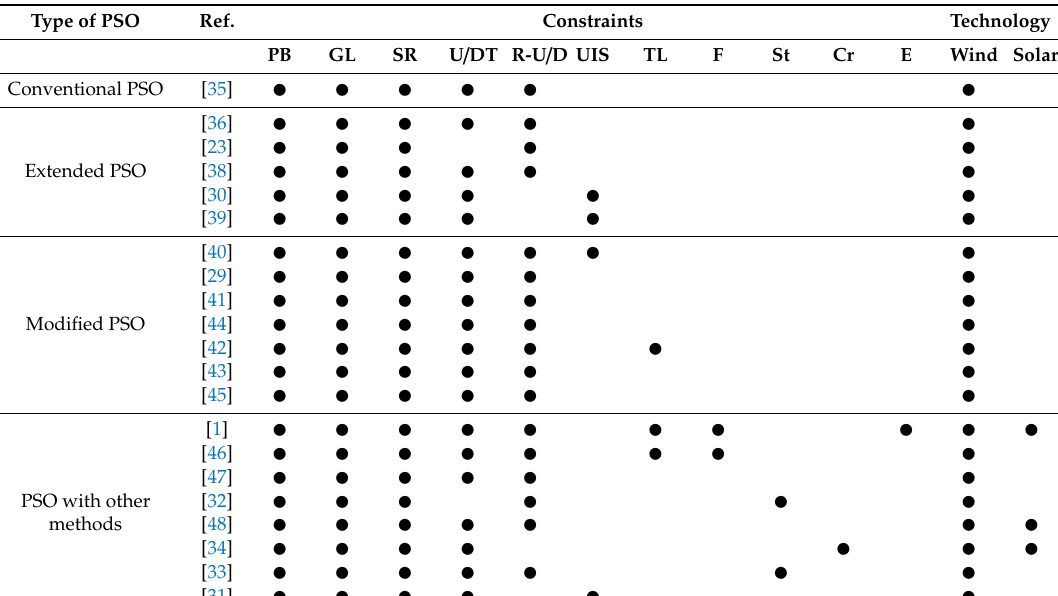
Table 5. Constraints and